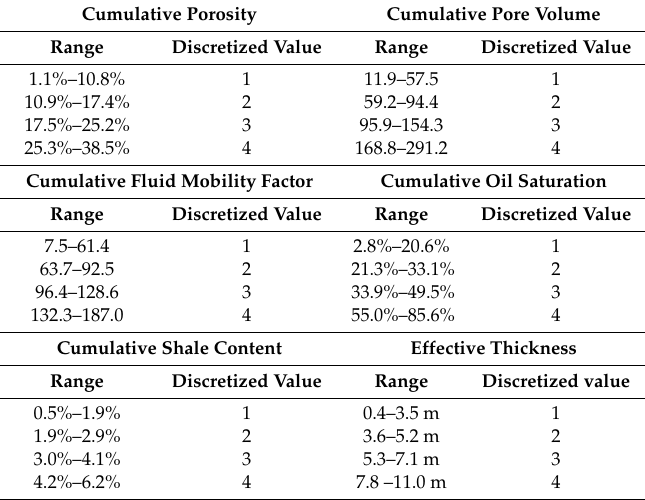
Table 2. Discretization results of the reservoir property